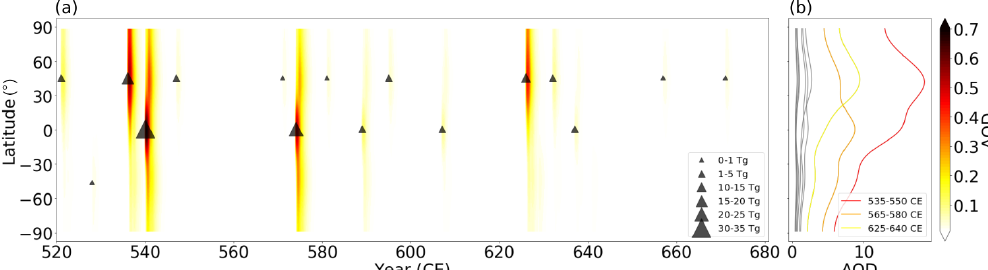
Figure 1. (a) Zonal mean volcanic forcing (aerosol optical depth, AOD) for the study period (520–680CE) and (b) zonal mean accumulated AOD (520–680CE) in 15-year bins from the reconstructed volcanic forcing of Toohey and Sigl (2017). The three 15-year periods with the highest volcanic forcing are highlighted in color and labeled. The triangles in (a) highlight the zonal locations and different strength in terms of stratospheric sulfur injection of all volcanic eruptions as specified in the legend (Tg = 10 12 g). Table 1. Volcanic forcing and stratospheric sulfur injection for eruptions used in this study (based on eVolv2k; Toohey and Sigl, 2017). Details for the Toohey et al. (2016a) 536 and 540CE reconstruction based on MAECHAM-HAM are added. The four and two, respectively, largest eruptions are highlighted as bold text. Eruption Eruption Eruption latitude S [Tg] Max global Reference year month AOD